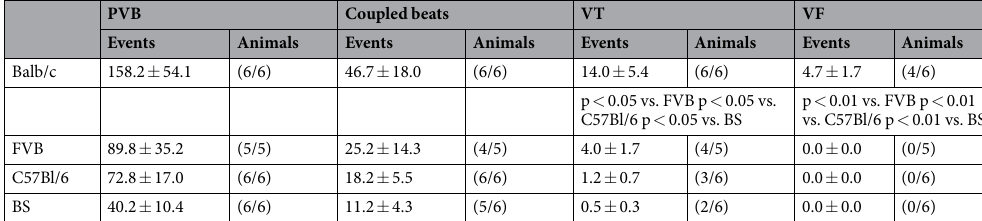
Table 2. Occurrence of ventricular arrhythmias under β -adrenergic stimulation. Total number of arrhythmic events during β -adrenergic stimulation and fraction of animals in which these arrhythmias occurred per group and subclass of arrhythmic event. Premature ventricular beats (PVB); coupled beats, e.g. couplets; ventricular tachycardic events (VT) and ventricular fibrillation (VF). Data is given as mean ± SEM. Statistical significances refer to the number of arrhythmias per group and were calculated using one-way ANOVA followed by Newman-Keuls post-hoc test. Balb/c n = 6, C57Bl/6 n = 6, BS n = 6, FVB n =